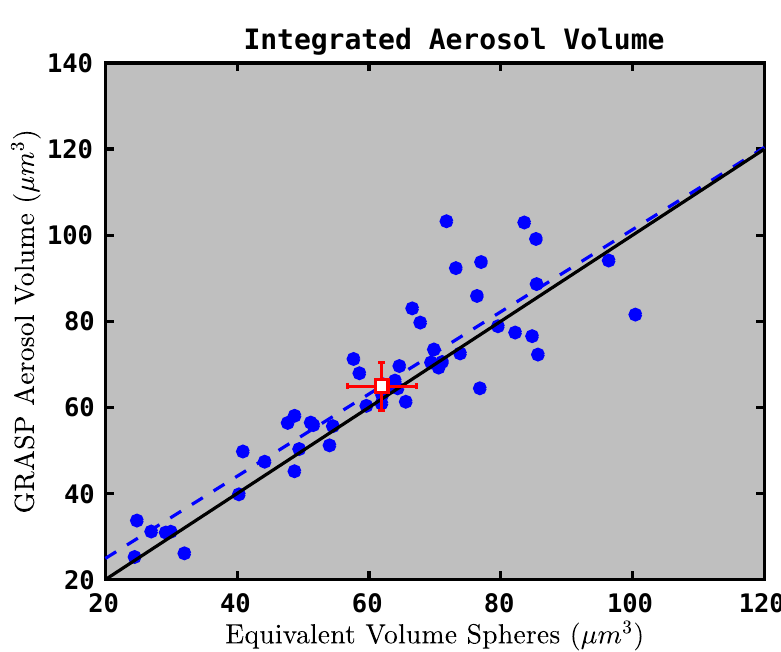
Figure 11. Total aerosol volume for GRASP and APS equivalent volume spheres. GRASP retrievals subsampled to an equivalent solar zenith angle of 50 ◦ ; APS sphere sizes determined using χ ∗ Red square and error bars represent means and two standard deviations of the means for the blue points. Solid line is 1:1 and dashed line represents linear regression; see Table 3 for regression